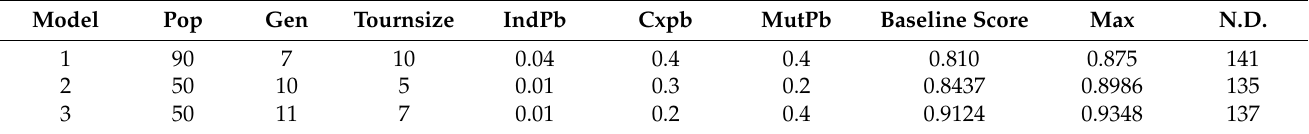
Table 1. Optimal configuration for each